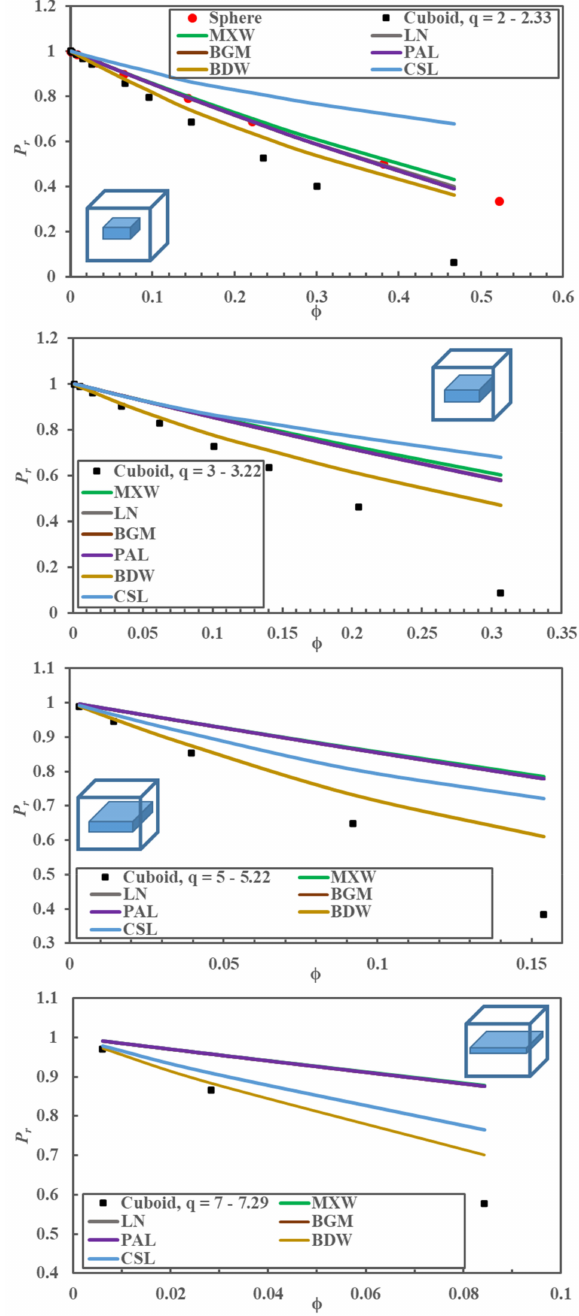
Figure 4. A comparison of the relative permeability of MMMs obtained numerically with the ones predicted by the six models presented in Table 1 as a function of the filler volume fraction ( φ ). The comparison is made for a polymeric elementary unit containing an impermeable nanoparticle: A sphere and cuboids with four di ff erent ranges of the aspect ratio ( q ) ([2.0, 2.3], [3.0, 3.2], [5.0, 5.2], [7.0, 7.3]). Acronyms of each model are defined in Table